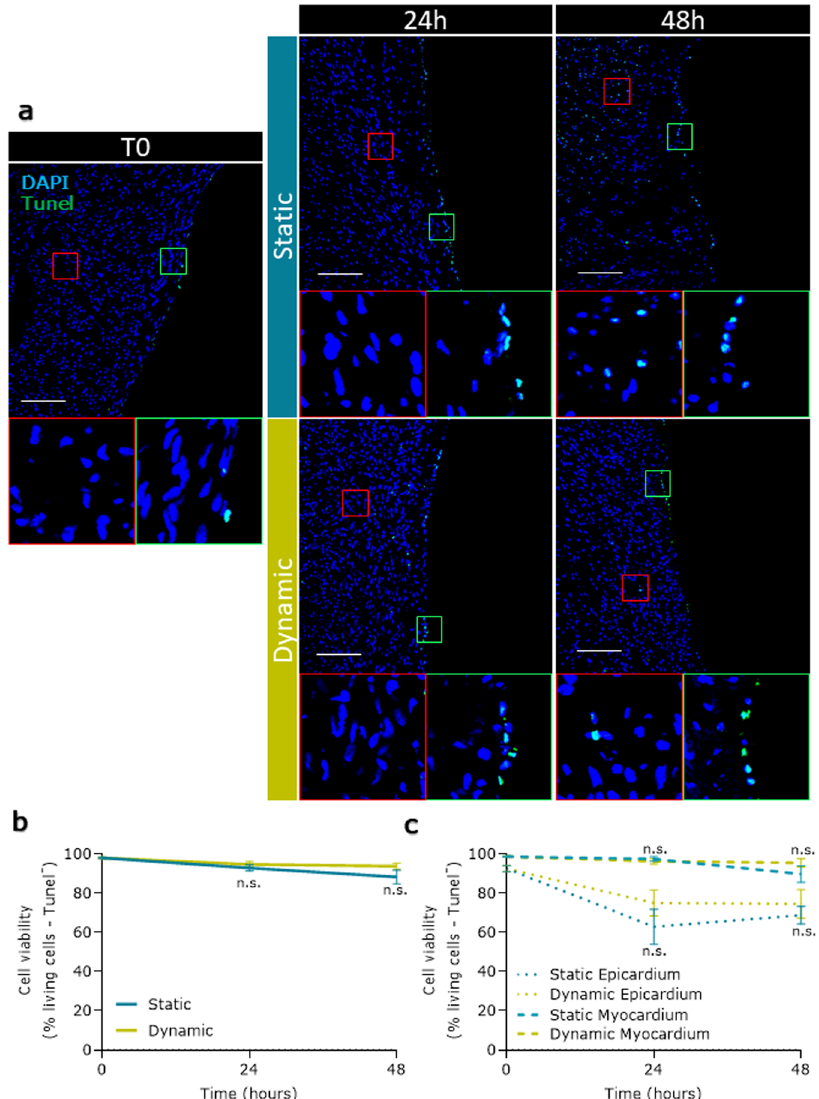
Fig. 4 Apoptosis levels in cultured epicardial slices. Apoptotic cells were evaluated by ApopTag detection kit assay ( a ); graphs report a fraction of non-apoptotic cells as a percentage of the total nuclei in the slice ( b ) and independently calculated fraction for myocardium and epicardium ( c ). N of pigs = 3 – 6, number of slices: T0 = 13, Stat 24 h = 7, Dyn 24 h = 4, Stat 48 h = 7, Dyn 48 h = 5. All graphs display data as mean ± SEM. n.s. not signi fi cant vs. Static control. Scale bar, 100